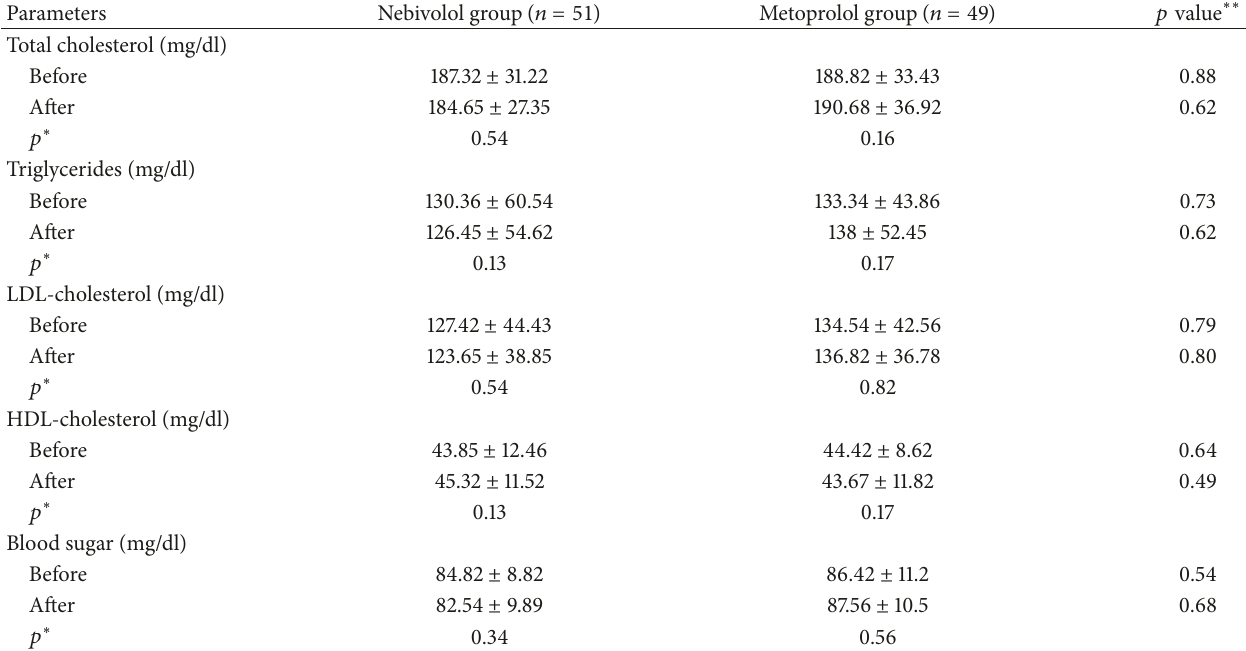
Table 2: Comparison of the lipid profile and blood sugar between two